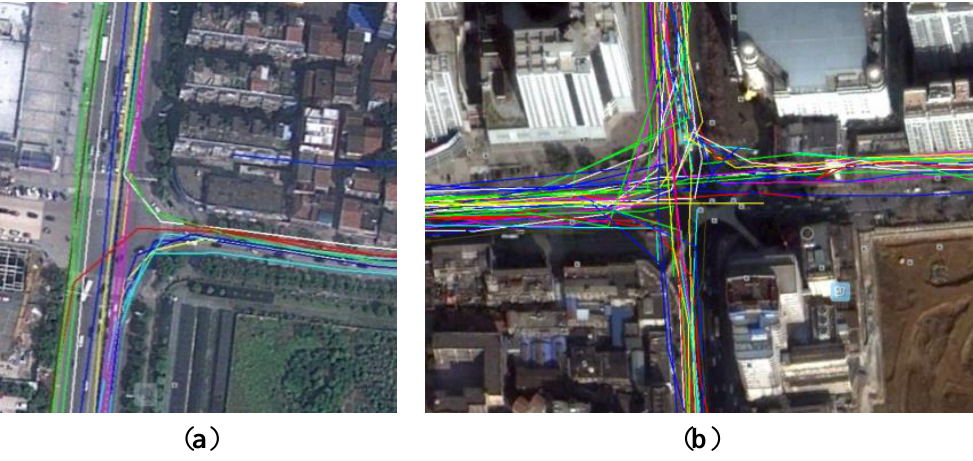
Figure 14. The overlay of image and trajectories. ( a ) shows the tracking results of one intersection; ( b ) indicates the tracking results of another